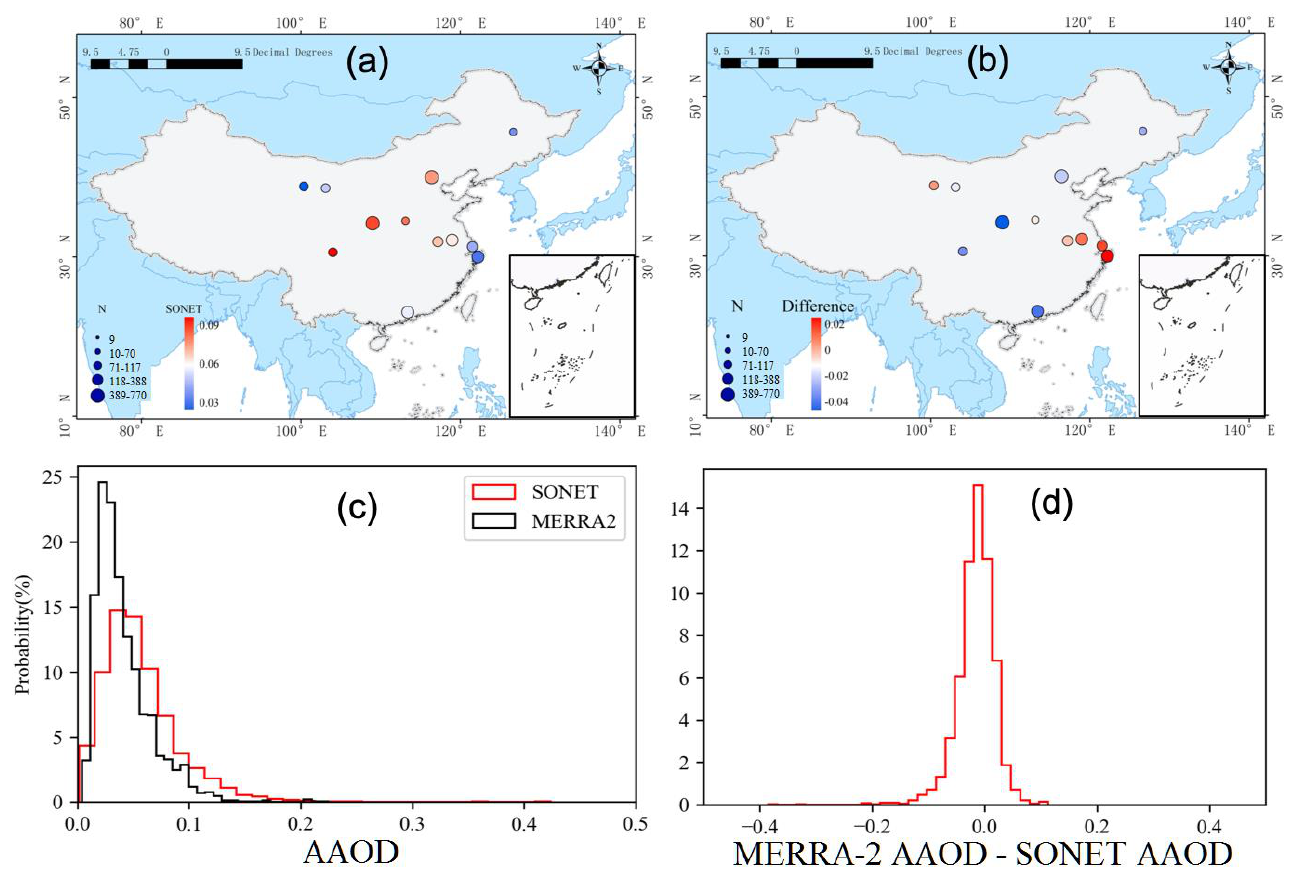
Figure 7. Same as Figure 3, but for AAOD.